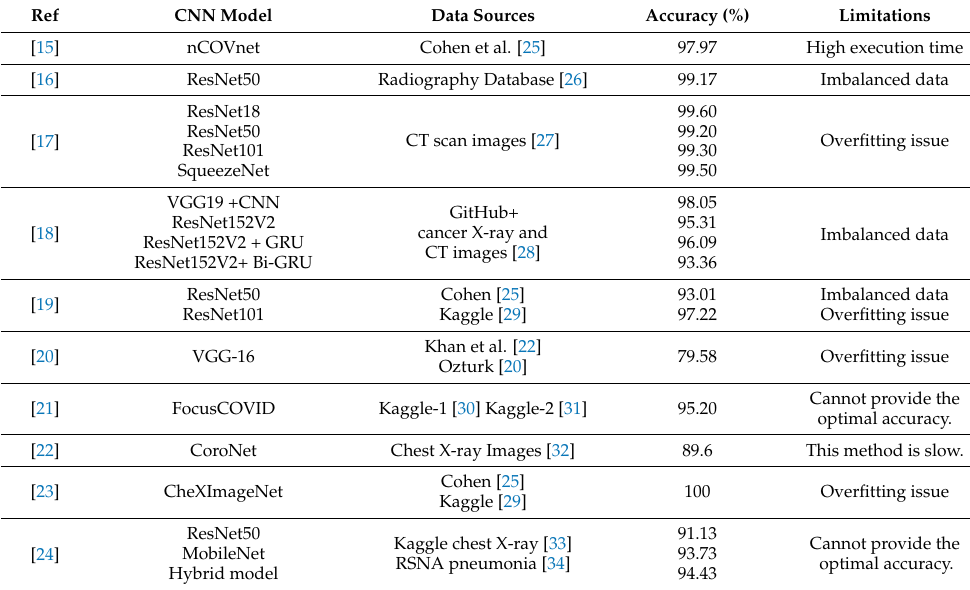
Table 1. Overview of studies using deep learning approaches for COVID-19